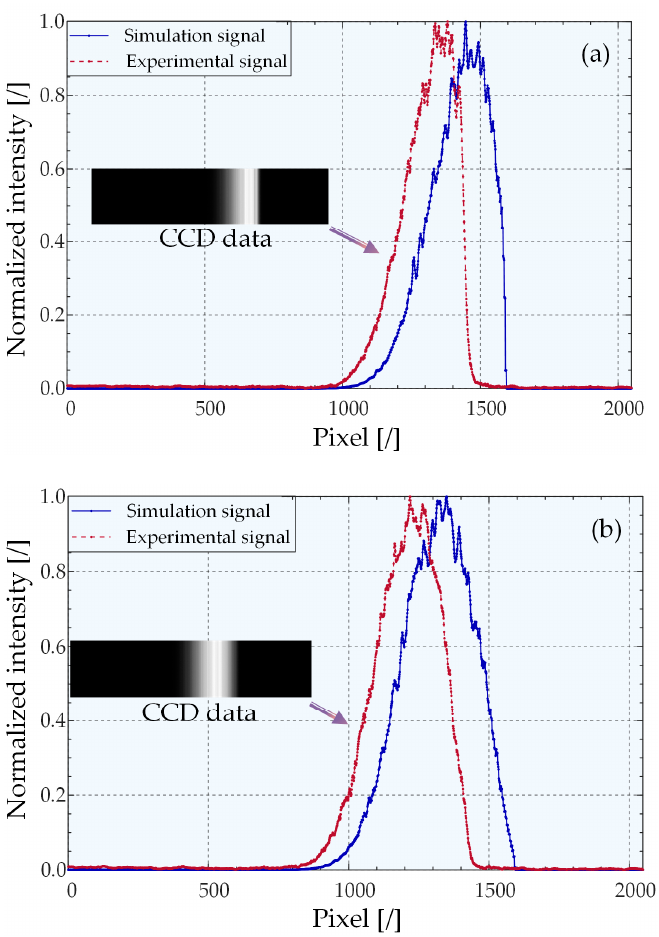
Figure 11. Simulation results and experimental data of light intensity-pixel distribution on a linear CCD. ( a ) (2°, 10°) on CCD1 and ( b ) (7°, 5°) on CCD2. CCD. ( a ) (2 ◦ , 10 ◦ ) on CCD1 and ( b ) (7 ◦ , 5 ◦ ) on